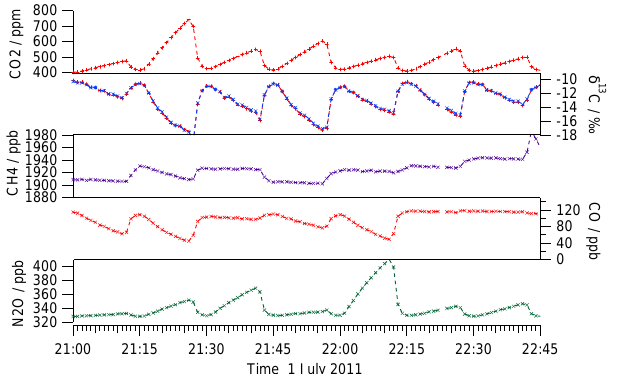
Fig. 15. N 2 O isotopologue emissions from pasture before and after addition of 15 N as nitrate to the soil on 17 December 2011. Ap- proximately 25mm of rainfall fell on 20–21 December 2011. See text for further